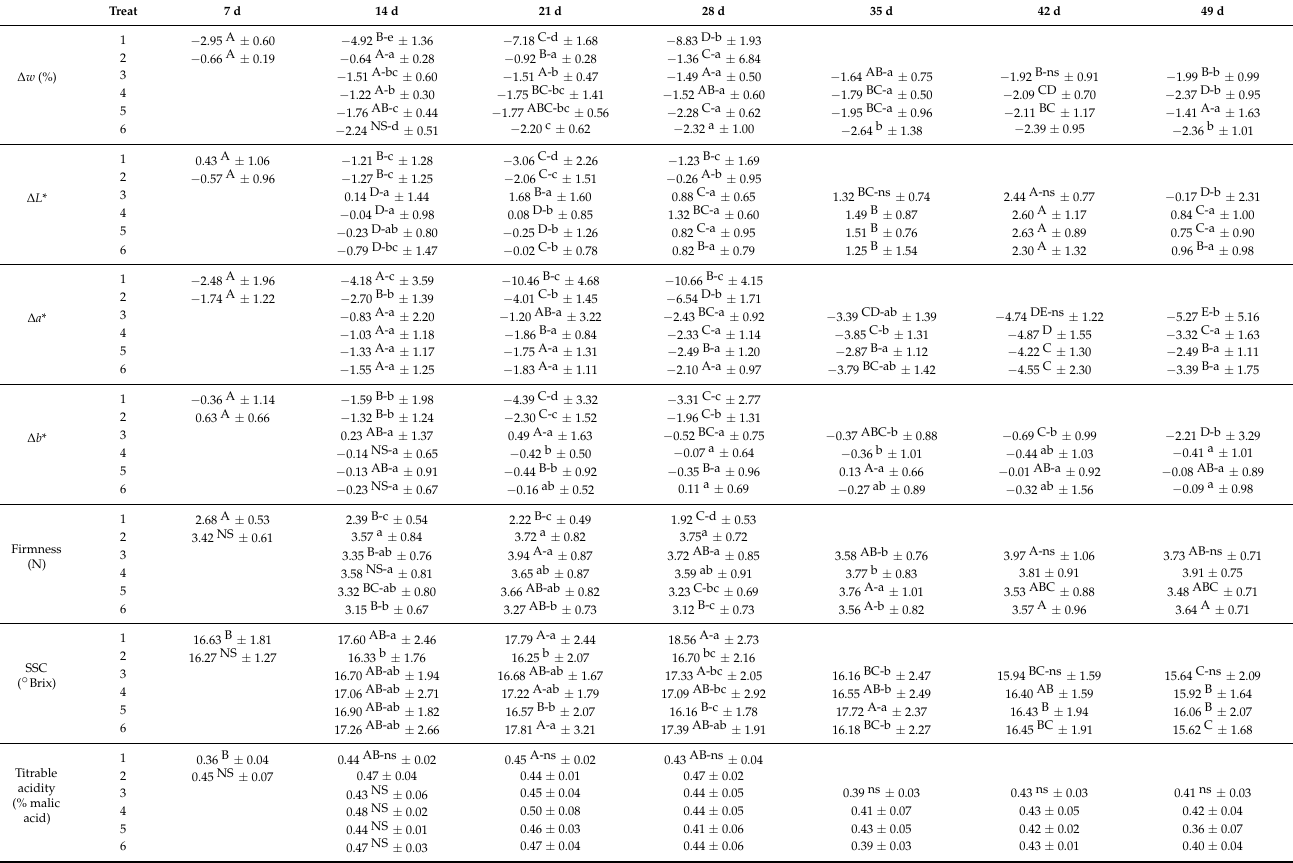
Table 4. Comparison of physicochemical variables between treatments and sampling days in 2019 evaluated in the sweet cherry cv. Satin conservation study. Treatment 1 was located at the FO under normal atmosphere conditions. Treatments 2 to 6 were located at the Research Centre. Treatment 2 was under normal atmosphere conditions. The atmosphere compositions of treatments 3 to 6